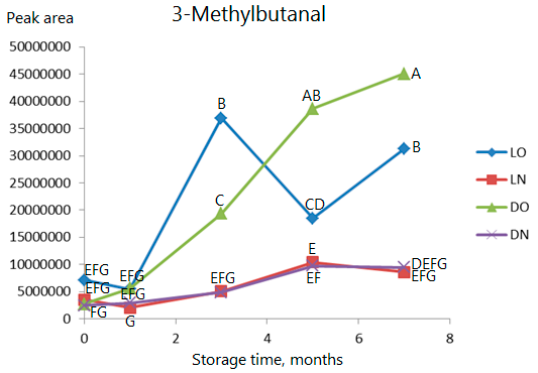
Figure 3. Effect of storage on levels of hexanal and ( E,E )-2,4-decadienal in the headspace of milled Roselle seeds. LO: light/oxygen (atmospheric air); LN: light/nitrogen; DO: darkness/oxygen (atmospheric air); DN: darkness/nitrogen. Observations marked with the same letter are not significantly different ( p > 0.05).